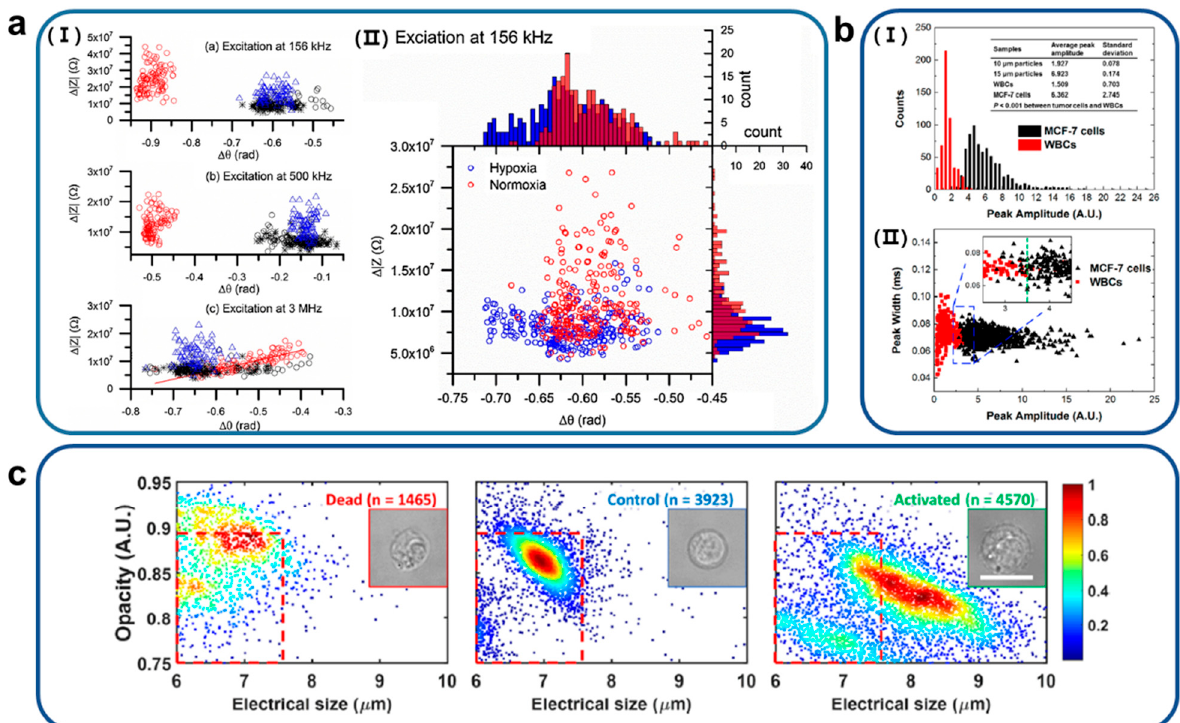
Figure 4. ( a ) (I) Differential impedance scatter plots that present discrimination of sickle RBCs and normal RBCs under normoxia at different frequencies. (II) Scatter values of ∆ |Z| of sickle RBCs under normoxia and hypoxia at electrical frequency 156 kHz. Reproduced with permission from [54]. Copyright Sensors and Actuator B: Chemical 2018. ( b ) (I) Distribution of impedance peak amplitudes versus counts of MCF-7 cells and white blood cells (WBCs) and (II) scatterplots that explain correlation between peak amplitudes versus peak width of MCF-7 cells and WBCs. Reproduced with permission from [56]. Copyright American Chemical Society 2017. ( c ) Profile of opacity versus electrical size of dead lymphocytes, normal lymphocytes and activated lymphocytes. Profiling opacity versus biophysical size that presents a characterization of peripheral blood mononuclear cells (PBMCs) treated with phytohemagglutinin (PHA). Reproduced with permission from [57]. Copyright Sensors and Actuators B: Chemical 2021.